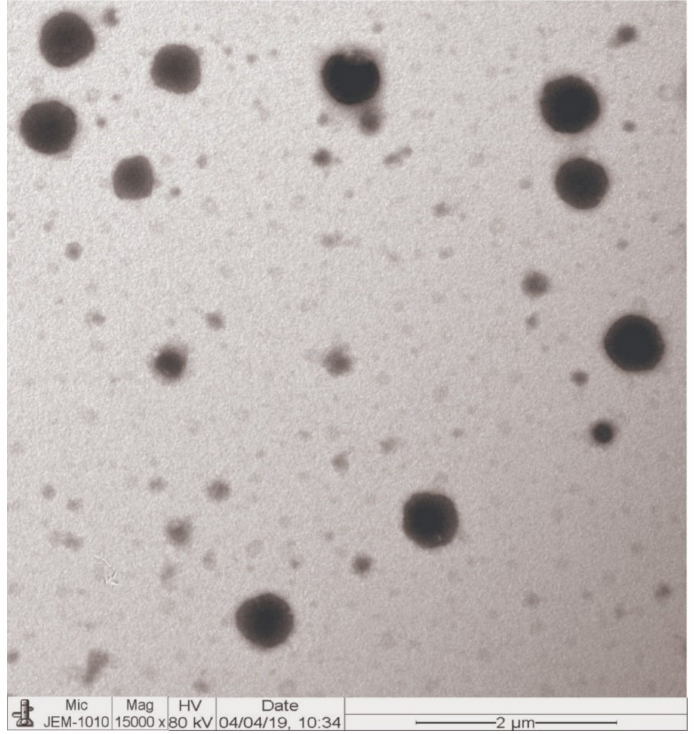
Figure 4. Transmission electron microscopy (TEM) images of optimized DFL-loaded L-P-NPs (F3). MIC: minimum inhibitory